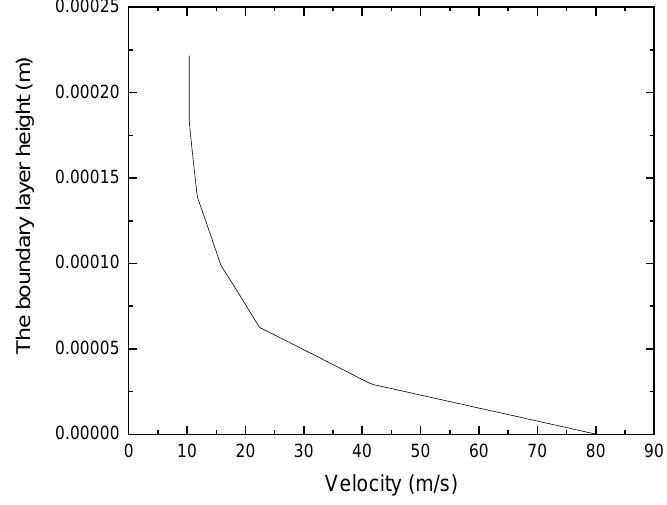
Figure 7. Boundary layer velocity distribution.